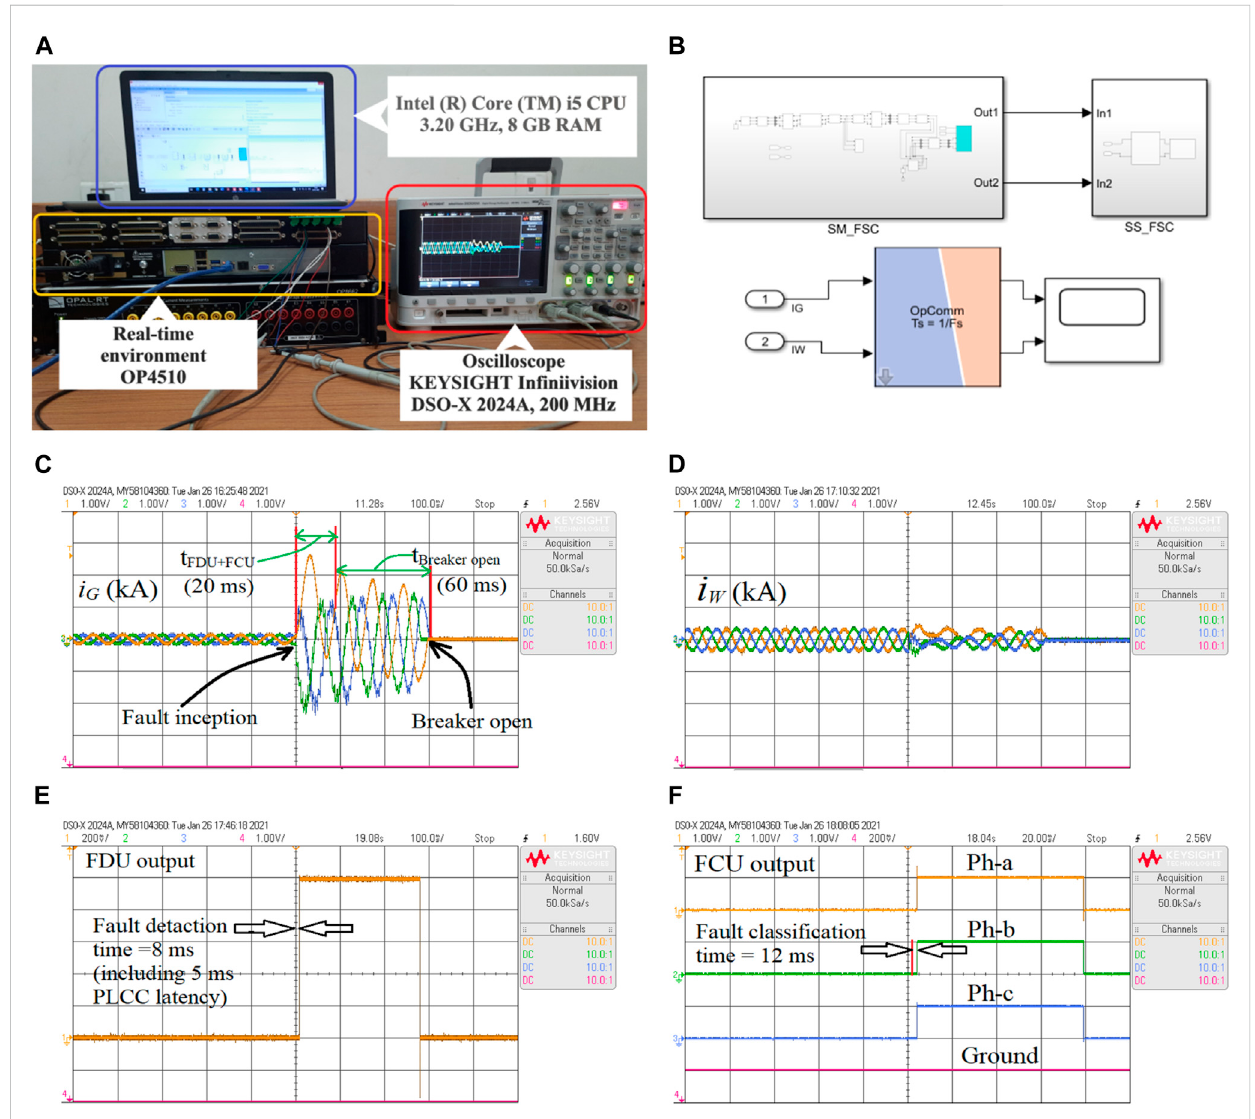
FIGURE 16 Results on the real-time environment: (A) real-time experimental setup, (B) Simulink in RT-LAB software, (C) grid-side current, (D) wind farm-side current, (E) FDU output, and (F) FCU